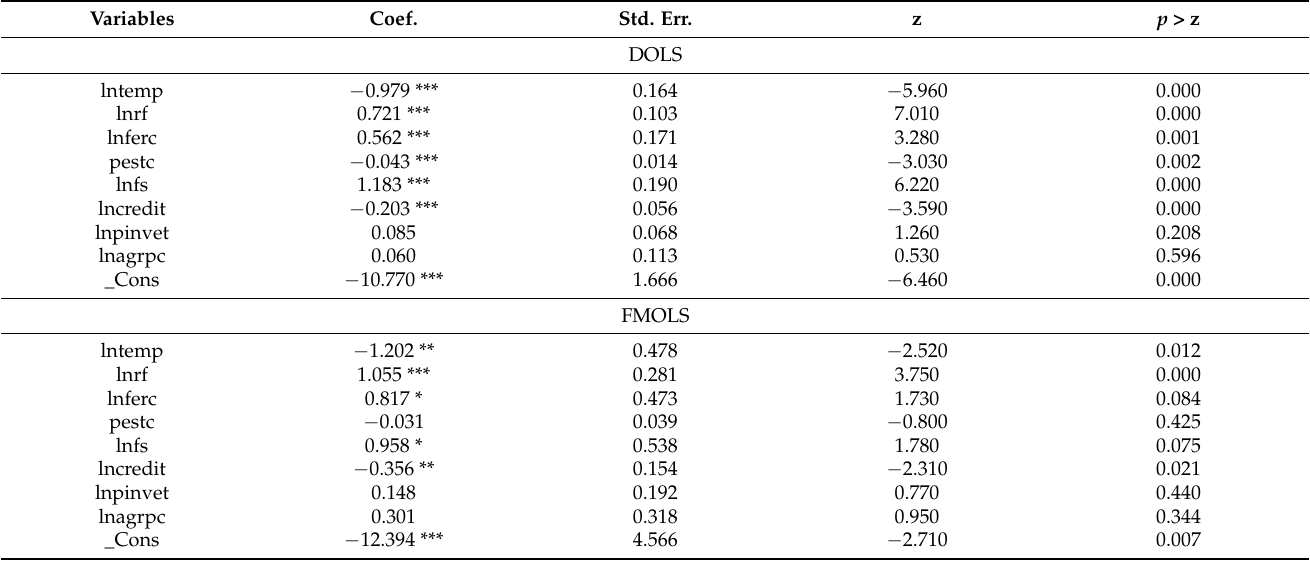
Table 6. Benchmark results.